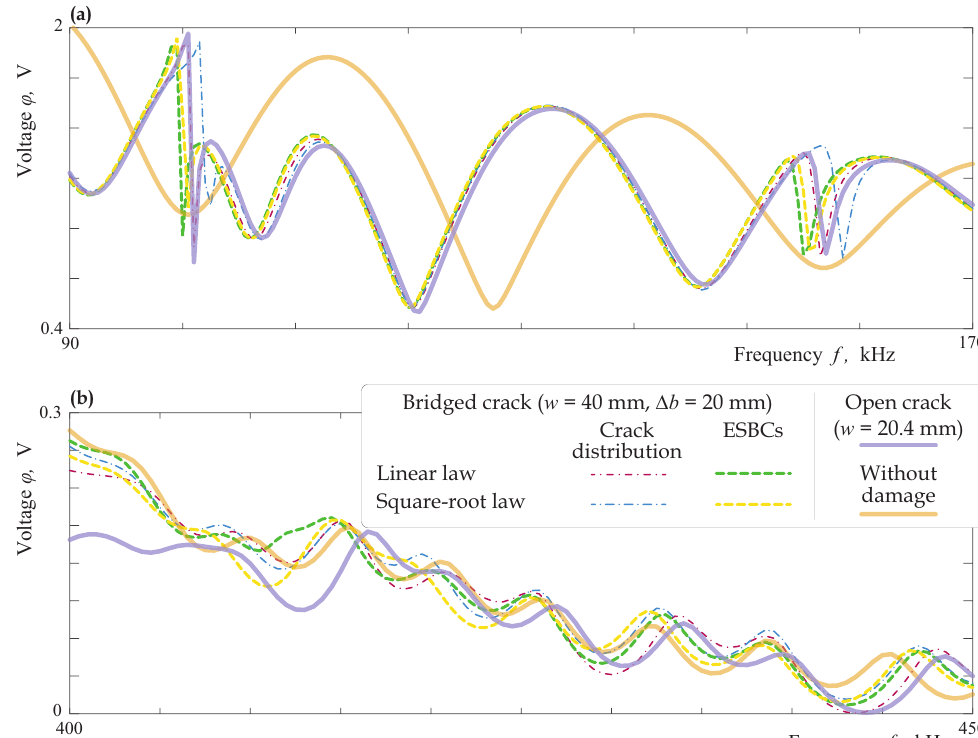
Figure 19. Voltage ϕ ( f ) sensed by PWAT at the surface of the laminate with interfacial bridged crack of length w = 40 mm ( ∆ b = 20 mm) modelled as an array of open micro-cracks and via the ESBCs at lower ( a ) and higher ( b )